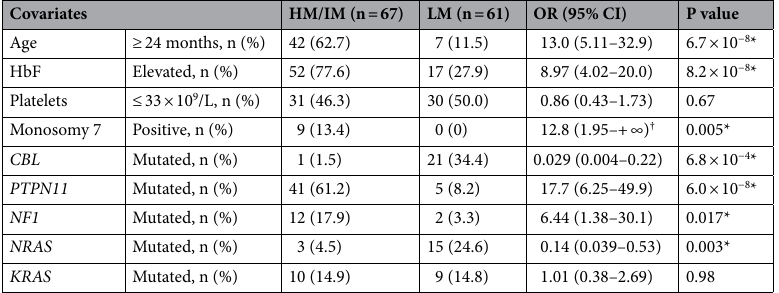
Covariates HM/IM (n = 67) LM (n = 61) OR (95%